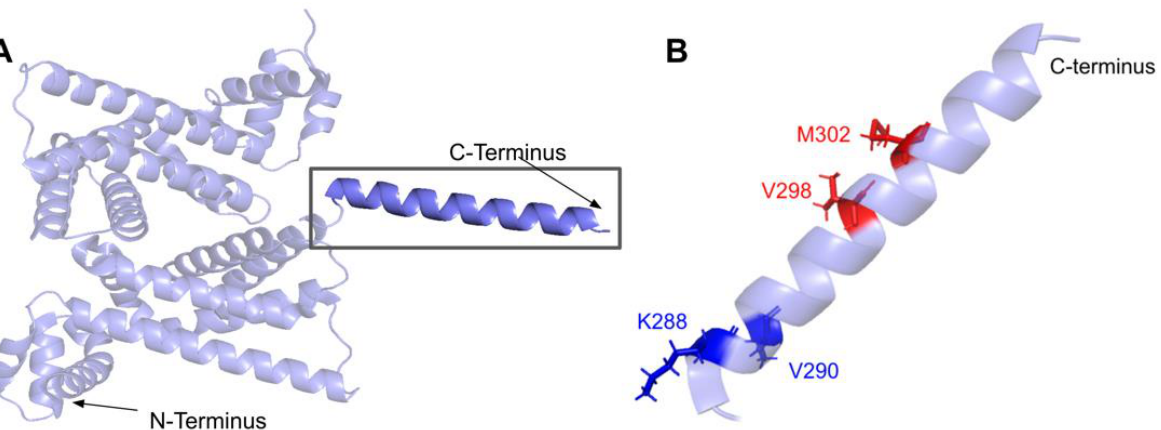
Figure 32. SNVs found in α10 of COQ9. ( A ) α10 highlighted on COQ9 dimer structure (PDB: 6AWL), corresponding to residues T286 to L311. ( B ) Locations of SNVs are depicted. Residues are colored according to their corresponding SNVs in Figure 28.